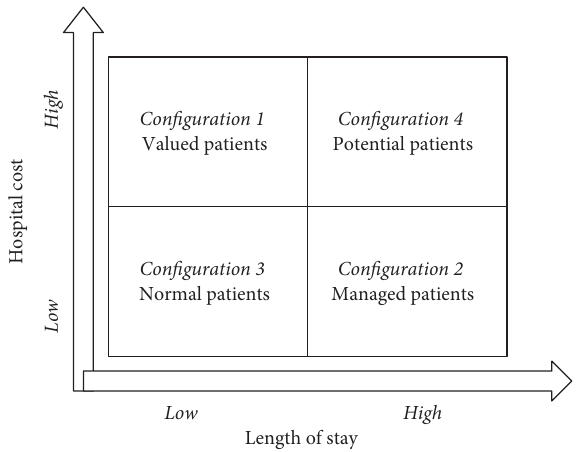
Figure 4: Inpatient